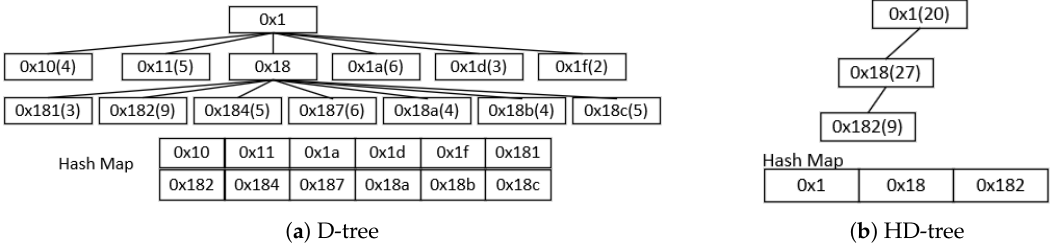
Figure 3. Example of D-tree and half decomposition tree (HD-tree) in four-dimensional